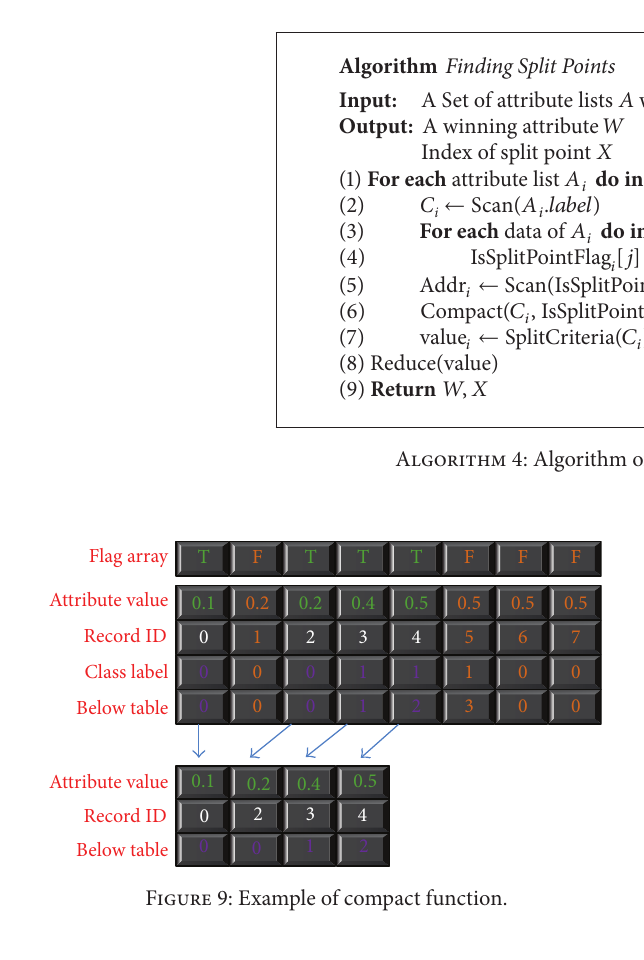
Algorithm 3: Algorithm of reduce function.